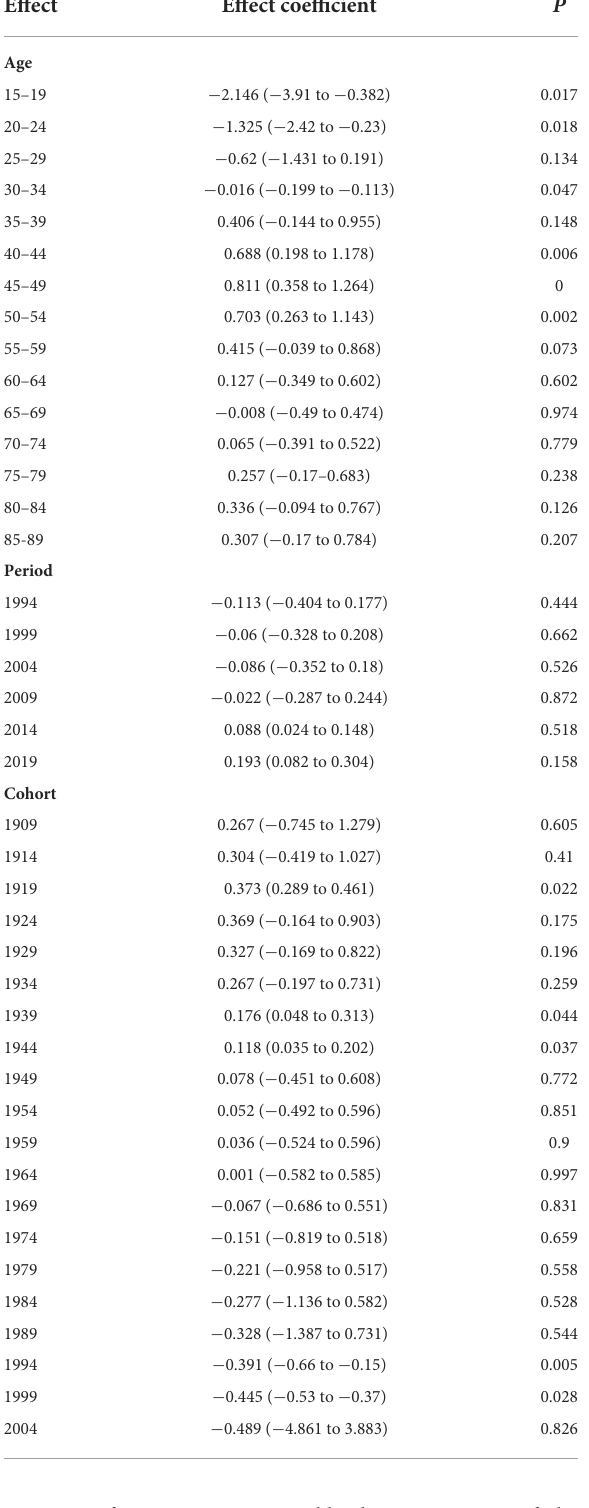
TABLE 2 The results of age-period-cohort